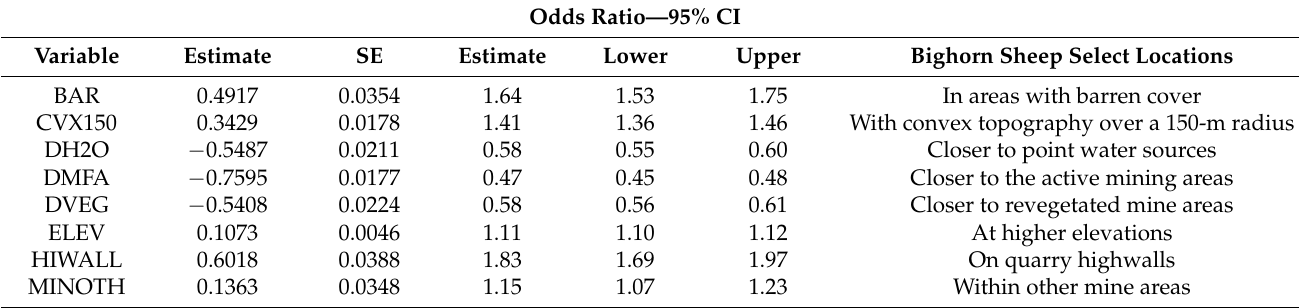
Table A1. Logistic regression coefficients estimated from resource selection function (RSF) for desert bighorn sheep ( Ovis canadensis nelsoni ) in proximity to active limestone mining operations in the San Bernardino Mountains, California, USA, 2006–2009